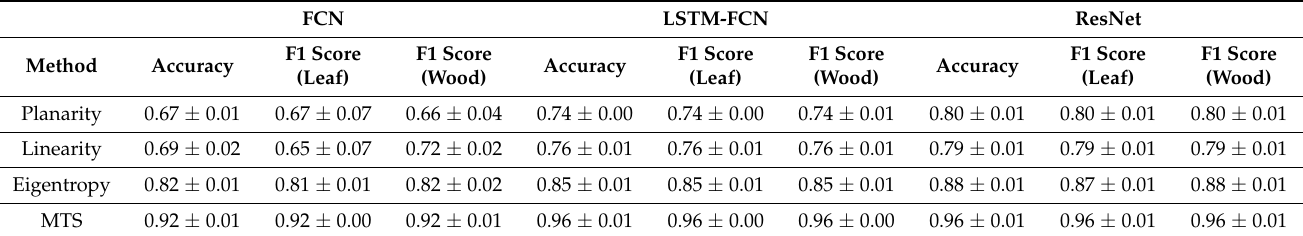
Table 2. Comparison of univariable (UTS) and multivariable time series (MTS) model on FCN, LSTM-FCN, and ResNet using Precision , Recall , F1 score, and Accuracy for training data; Accuracy means the corrected classified leaf and wood points against the total points (UTS: Planarity; Linearity; Eigentropy, MTS: Overall).